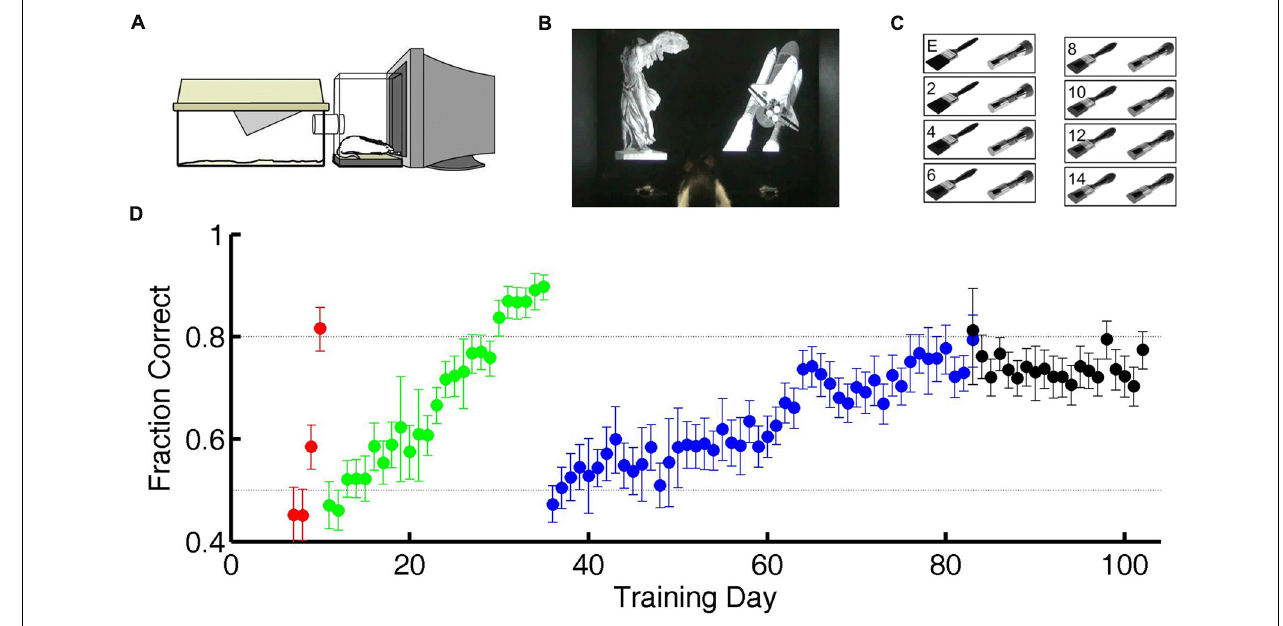
responses are valid, so performance is undefined (not plotted). For all subsequent shaping steps, each symbol shows the average performance on one task over one training day. Error bars show 95% binomial confidence intervals. Color indicates task: go to statue (shaping step 3, red ), discriminate statue from shuttle (shaping step 4, green ), discriminate flashlight from paintbrush exemplars (shaping step 5, blue ), or discriminate flashlight from paintbrush including exemplars and morph probe trials (shaping step 6, black ). Subjects were automatically graduated to the next task when performance exceeded 80% (upper dotted line) for at least 200 trials, and graduated from the final task when each morph level had been tested exactly 150